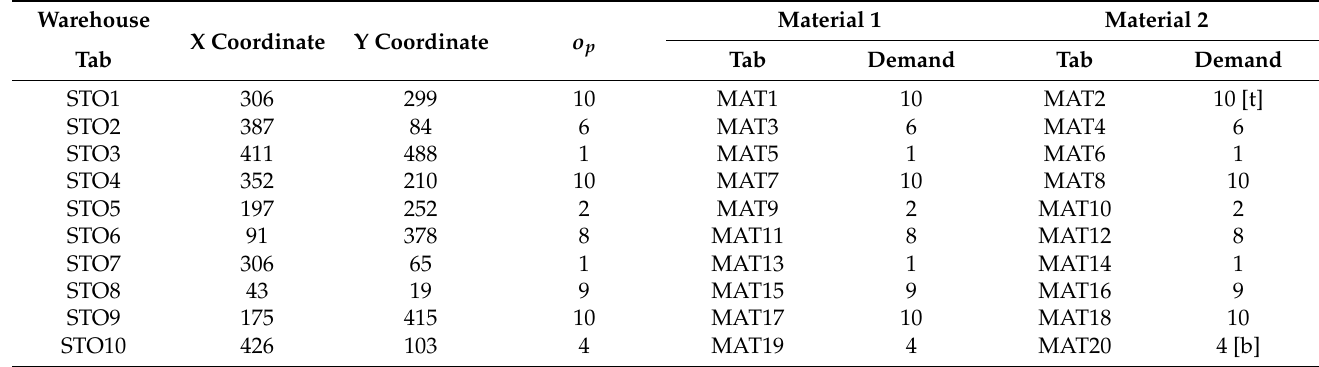
Table 8. Warehouse information of P01.